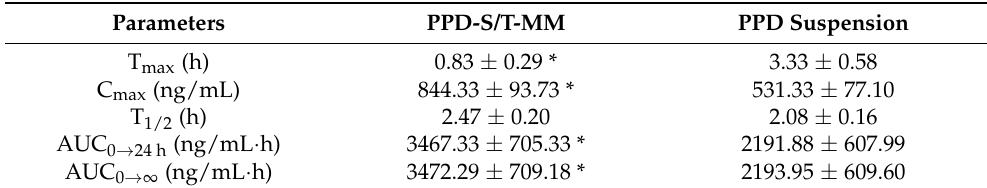
Table 6. Pharmacokinetic parameters of PPD after intragastric administration of PPD-S/T-MM or PPD suspension in rats (mean ± SD, n =